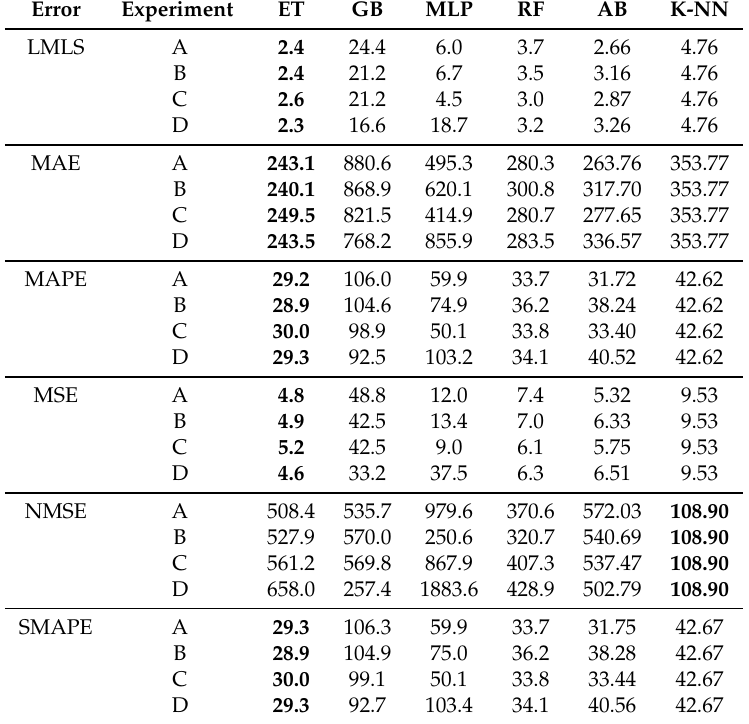
Table 1. Global model errors (multiplied by 10 5 ) for extremely randomized trees (ET), gradient boosting (GB), multi-layer perceptron (MLP), random forest (RF), adaptive boosting (AB), and k-nearest neighbors (K-NN).